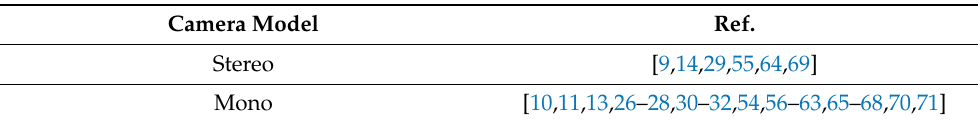
Table 10. The study of the distribution by image format in Figure 7b.